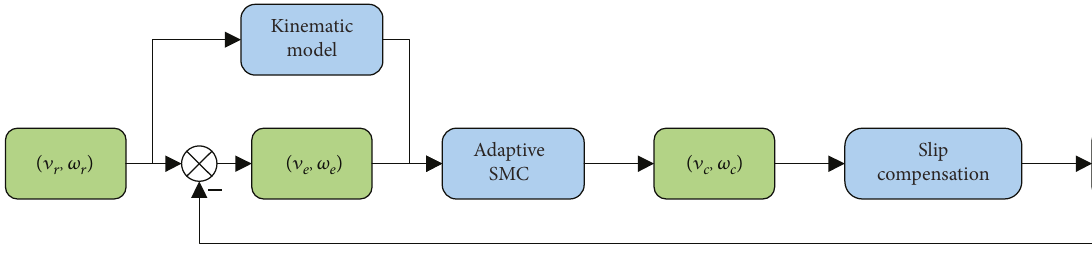
Figure 3: The main control loop.